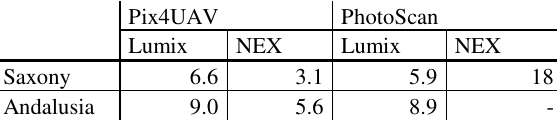
Figure 4. Height differences between differently from UAV generated point clouds and TLS displayed for an excerpt of the Saxonian DTM Different point densities influence the detail of surface reconstruction which is especially relevant for the larger plot in Andalusia. The increasing distance to the TLS amplifies the increase of incident angles and hence the increase of noise (S OUDARISSANANE ET AL . 2011) and occlusion effects. Furthermore, the convex slope shape causes additional unfavourable incident angle amplification. In Andalusia a tractor trail is chosen for detailed examination of occlusion effects (Figure 5). The DTM generated from TLS point cloud misses points in the depth of the trail. Thus, the meshed surface model underestimates the steepness. DTM processed with “PhotoScan” has the highest point density and should be sufficient to fill the gap, but the surface rebuilding is generally too smooth. Hence, the tractor trail is not correctly measured. The terrain model generated with “Pix4UAV” gives better results. It captures the tractor trail and mainly joins with the remaining surface.